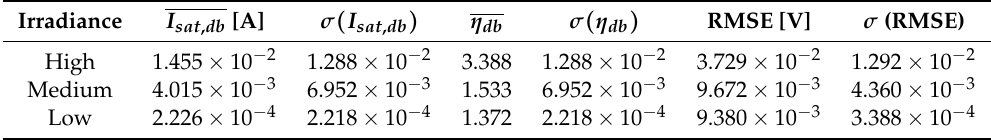
Table 9. Estimated parameters for bypass diode in submodule 3 for high, medium and low irradiances from experimental data and RMSE in the I-V curve